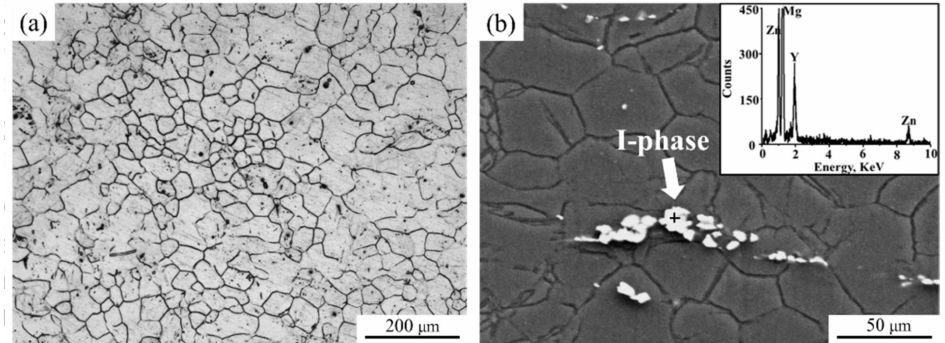
Figure 1. Microstructure of the homogenized Mg-2Zn-0.4Y alloy: ( a ) OM image; and ( b ) SEM